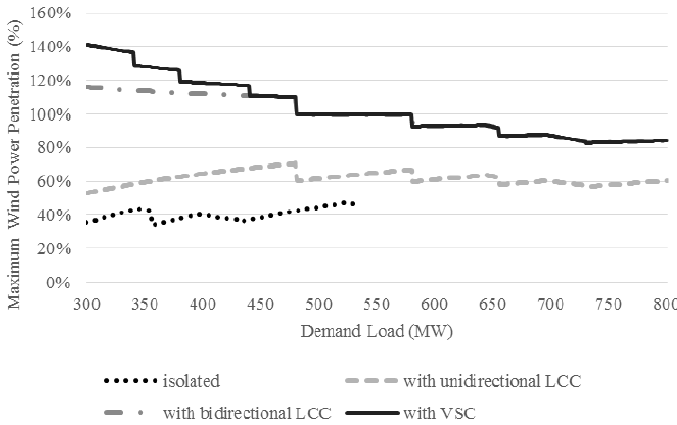
Figure 8. Wind power penetration rate according to HVDC interconnection.